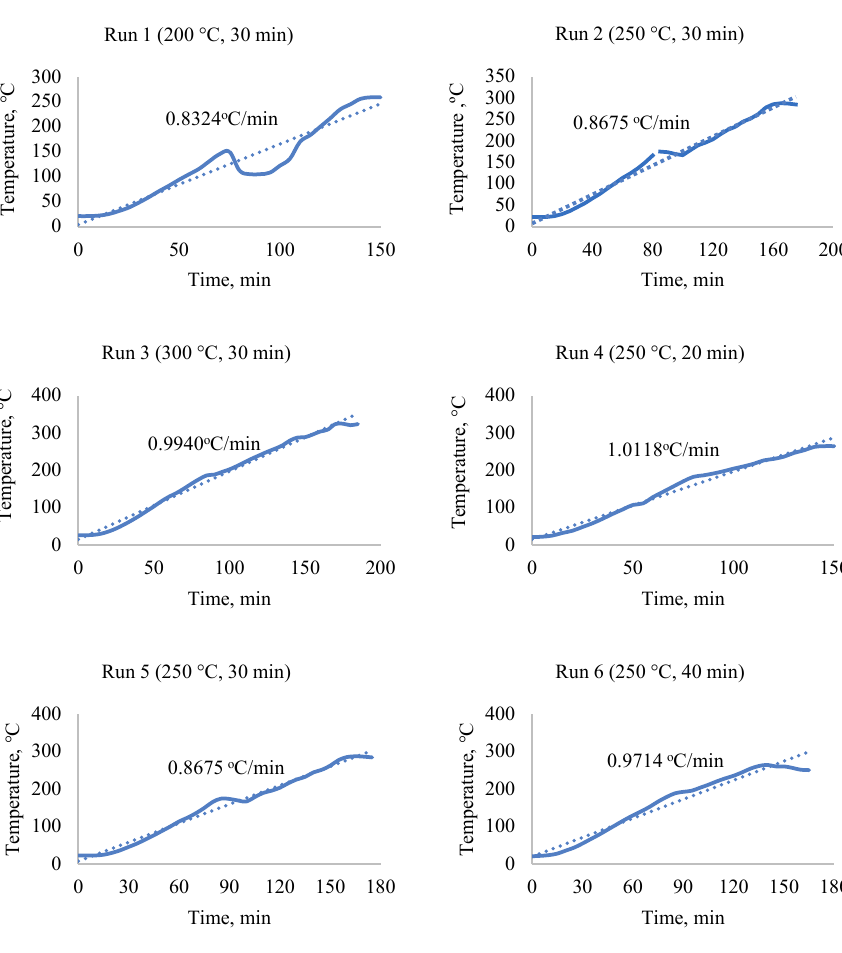
Fig. 3. The heating rate of each experimental